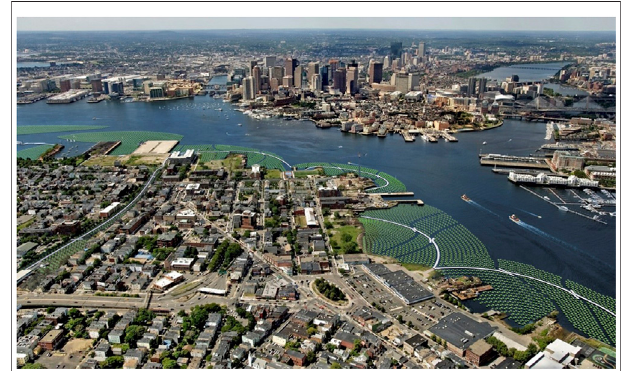
FIGURE 1 | Aerial view of a rendering of the Emerald Tutu (green circles) surrounding East Boston, MA. The white strips represent walkways through the mat which can be used by community members during calm